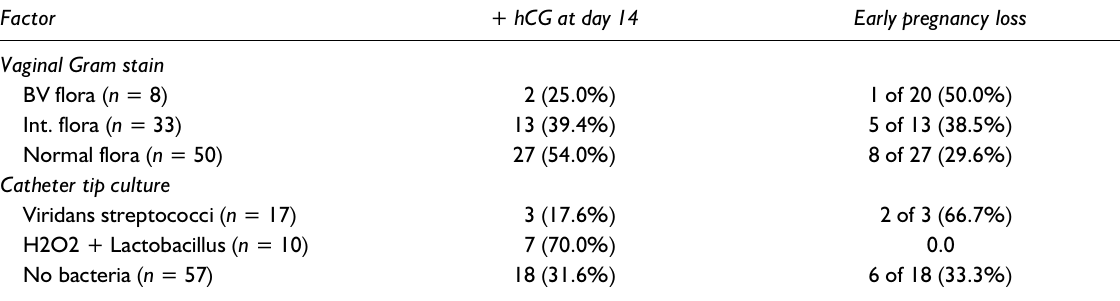
Table 1 Influences of vaginal and embryo transfer catheter microbiology on early pregnancy